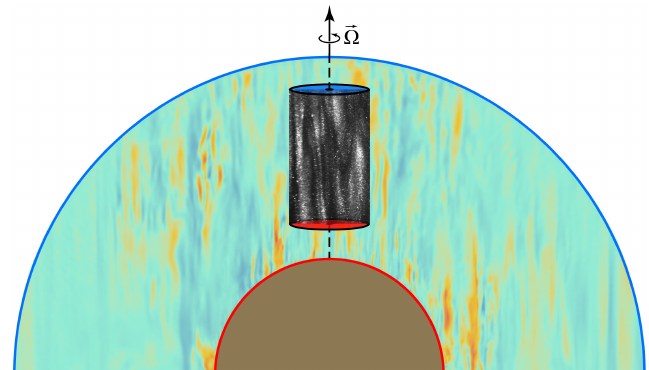
Figure 1. Schematic of the northern hemisphere of Earth’s core region, with a solid inner core (tan- colored) of radius r = 0.35 R core , rotating about the z-axis (dashed line) at rate (cid:126) Ω . The cylinder located at a high latitude and aligned with the rotation axis is representative of the laboratory containers used in this work. The interior of the cylinder is filled with an illustrative subset of the visualization of a geostrophically turbulent laboratory experiment ( E (top) edges of the experimental cell are red (blue) to represent the warm (cold) fluid under the presence of convection in parallel with the inner core boundary (core–mantle boundary). A meridional slice of the instantaneous radial velocity from a dynamo simulation ( E = 3 Pm = 0.05) adapted from [15] occupies the fluid outer core region. Orange (teal) indicates radially outward (inward)